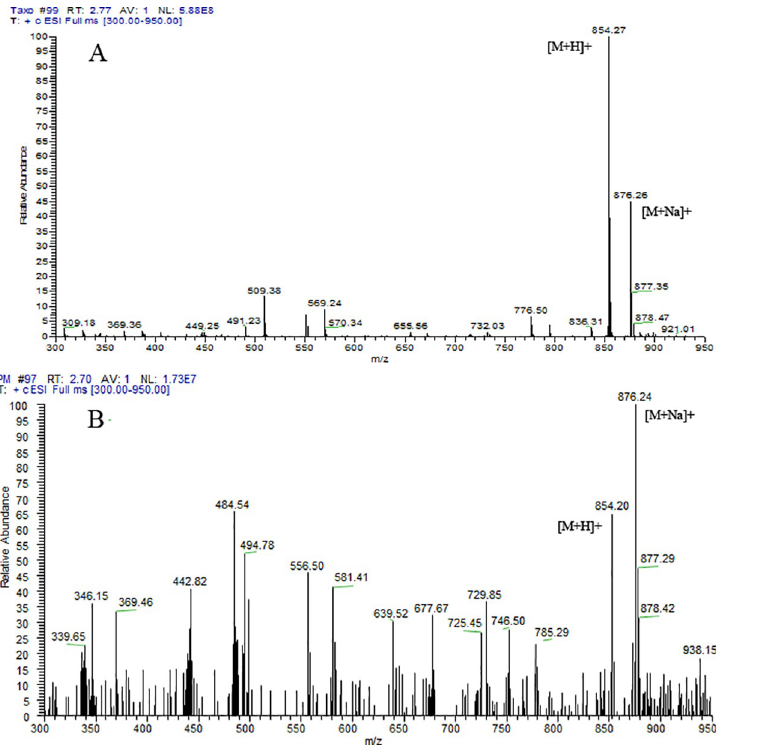
Fig 2. Mass spectra of taxol. (A) Standard paclitaxel. (B) Taxol from P . microspora .